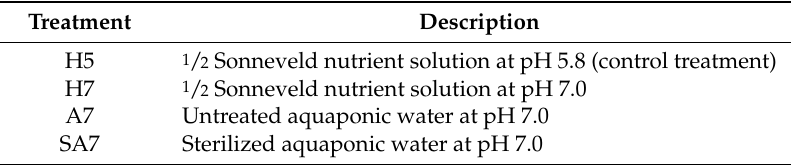
Table 1. Tabulation of the four treatments tested.